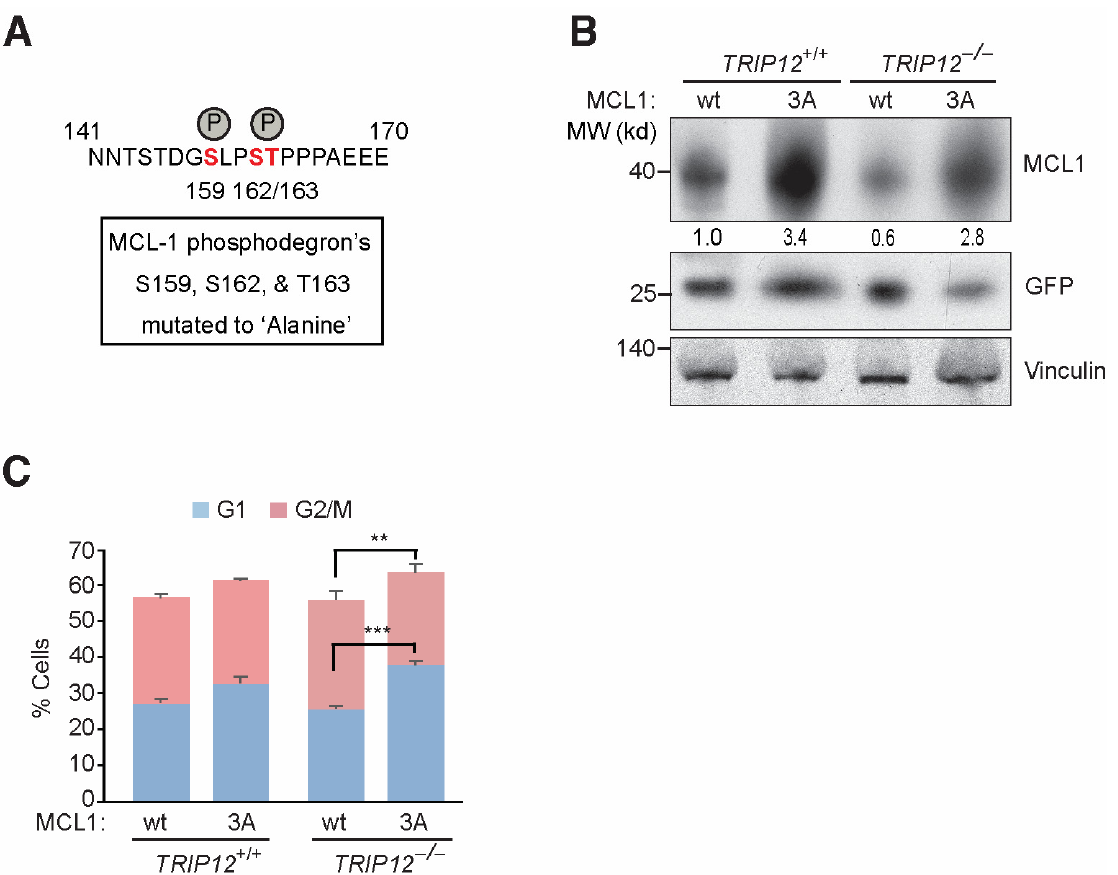
Figure 4. Efficient release from mitotic arrest in cells overexpression MCL ‐ 1 3A ‐ mutant. ( A ) Sche– matic of MCL ‐ 1’s GSK3 β phosphodegron mutated to alanine. ( B ) Western blot for indicated anti ‐ bodies in cells overexpressing MCL ‐ 1 wildtype and 3A ‐ mutant. Numbers under MCL ‐ 1 blot denotes densitometric quantification normalized to transfection control GFP. Vinculin antibody is used as a loading control. ( C ) MCL ‐ 1 wild type and mutant overexpressing mitotically synchronized TRIP12 depleted cells subjected to cell ‐ cycle analysis after 3 HR of release from mitotic arrest assessed by flow cytometry.